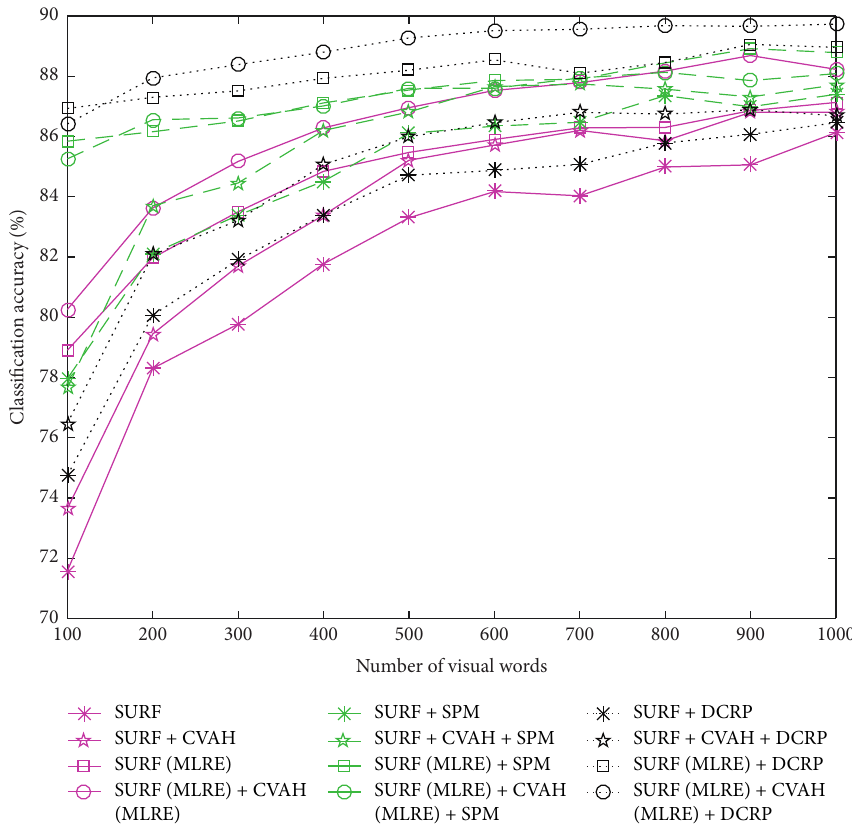
Figure 9: Effects of different spatial patterns on